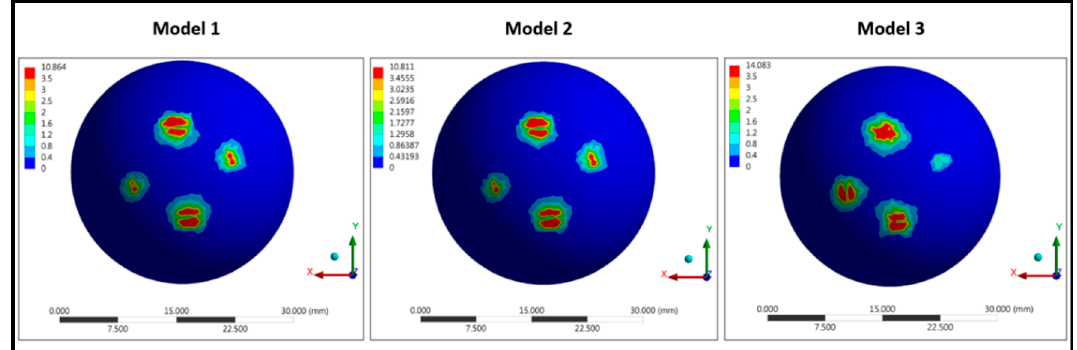
Figure 3. The distribution of von Mises stress on the string-bed.